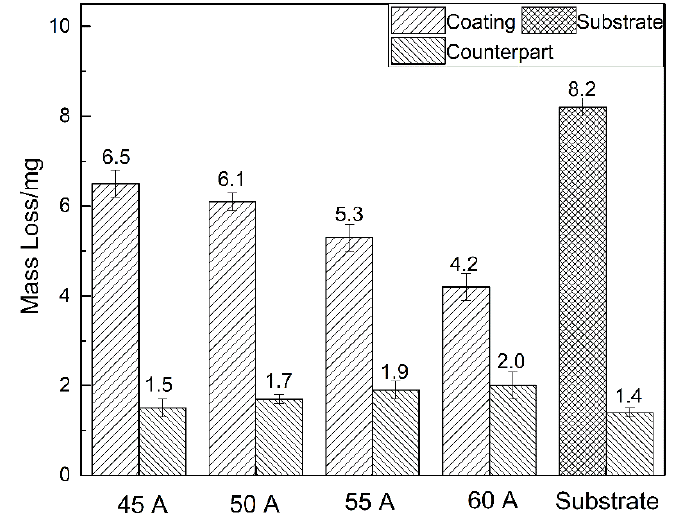
Figure 11. Wear mass loss of the coatings, CGI substrate and the corresponding counterparts.